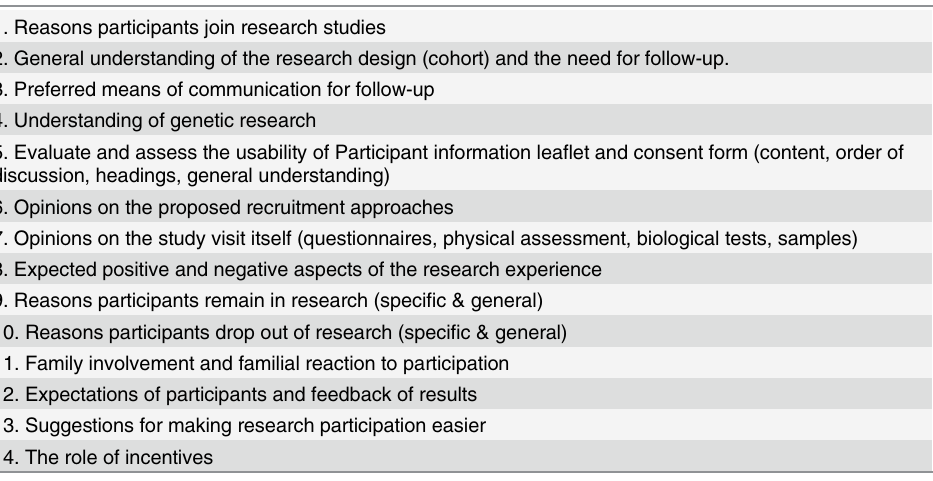
Table 1. Discussion topics for